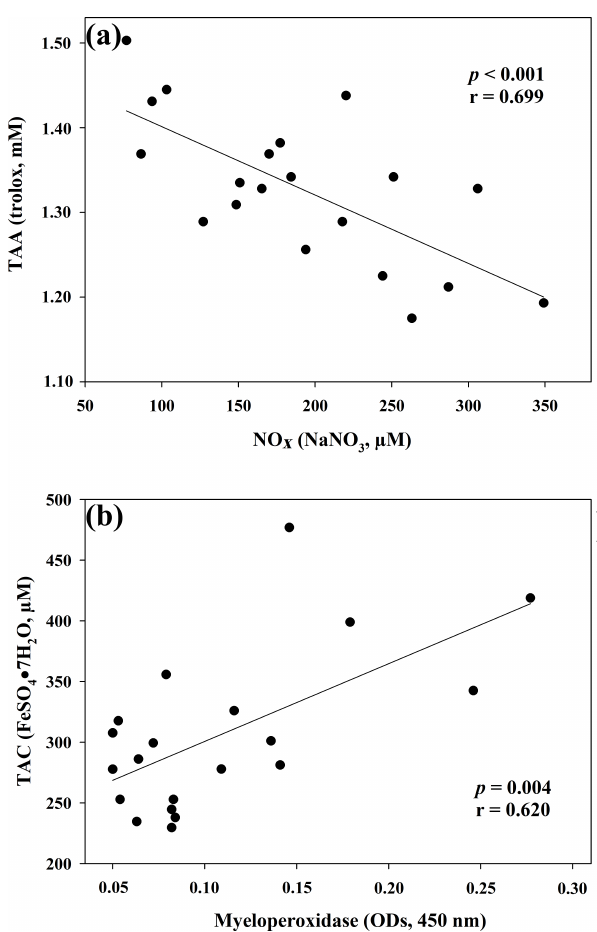
Figure 3. Regression analysis between total antioxidant activity (TAA) and nitric oxide metabolites (NO x ) (a) and between total antioxidant capacity (TAC) and myeloperoxidase (b) in goat kid